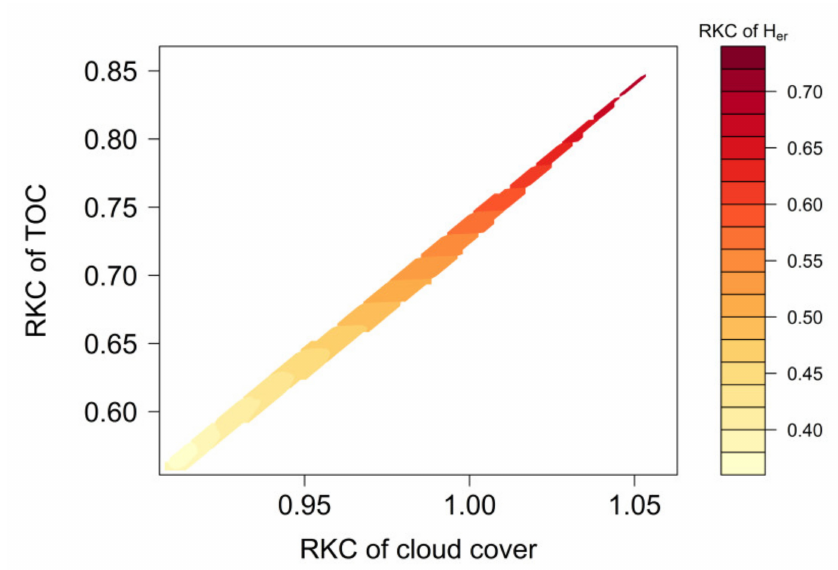
Figure 6. Dependence of running Kolmogorov complexity (RKC) of H er from RKC of TOC and cloud cover for a fixed window of